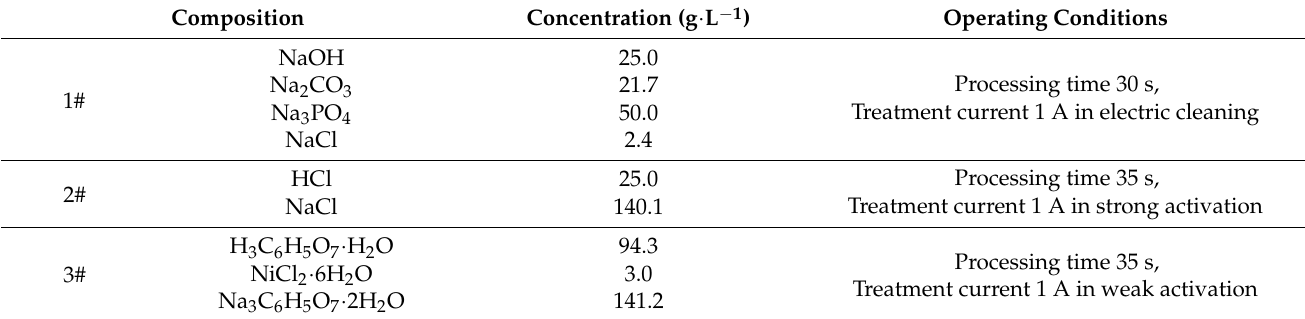
Table 1. Pretreatment solutions compositions, concentrations, and operating conditions.